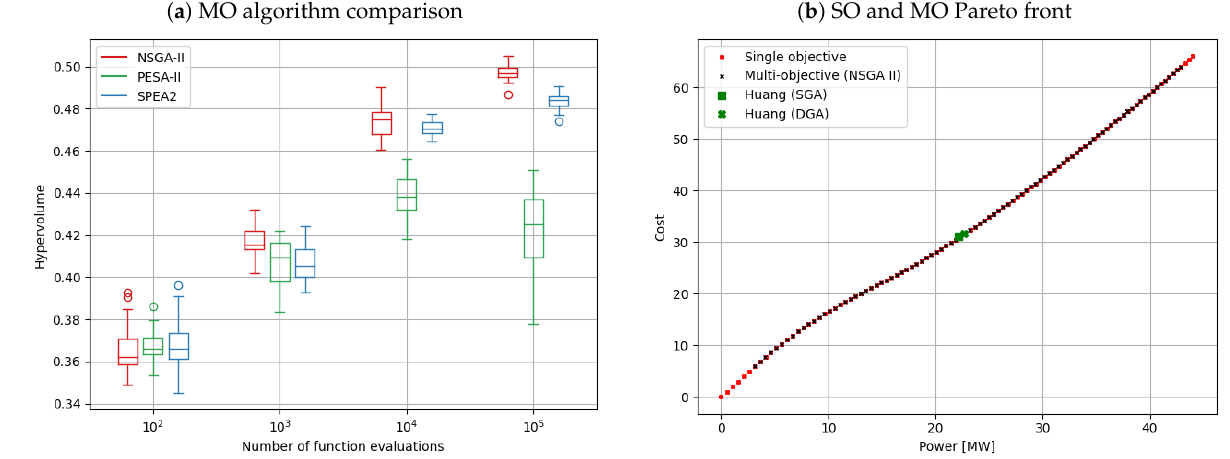
Figure 16. MO algorithm performance and Pareto front for case 3.